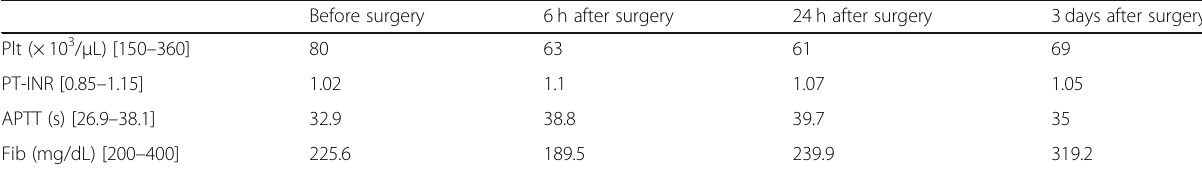
Table 1 Blood testing findings